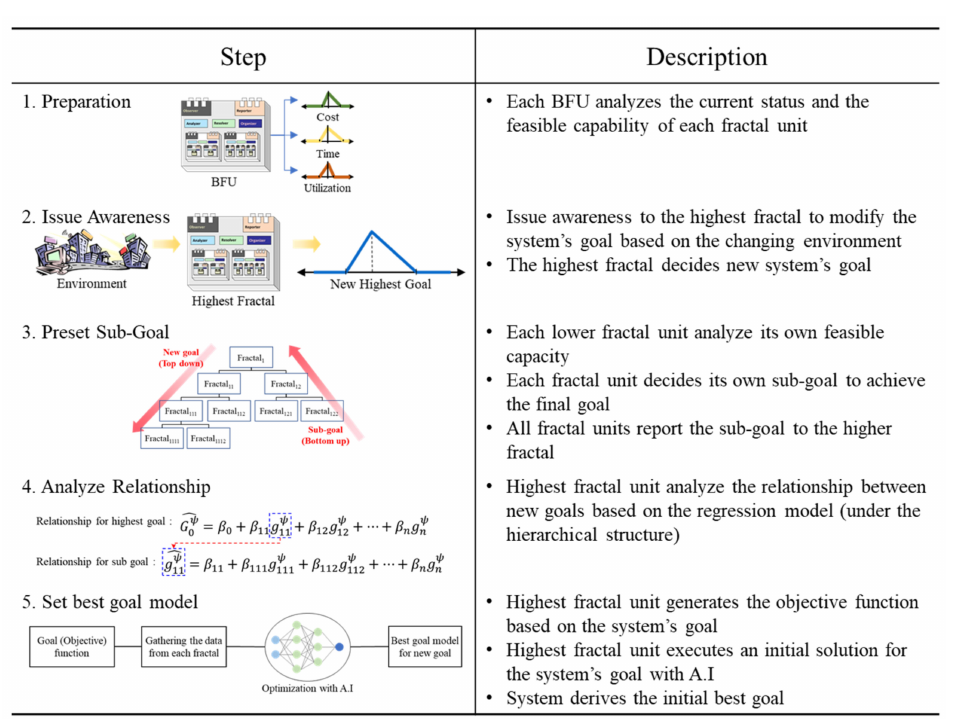
Figure 13. Mechanism of goal decision model